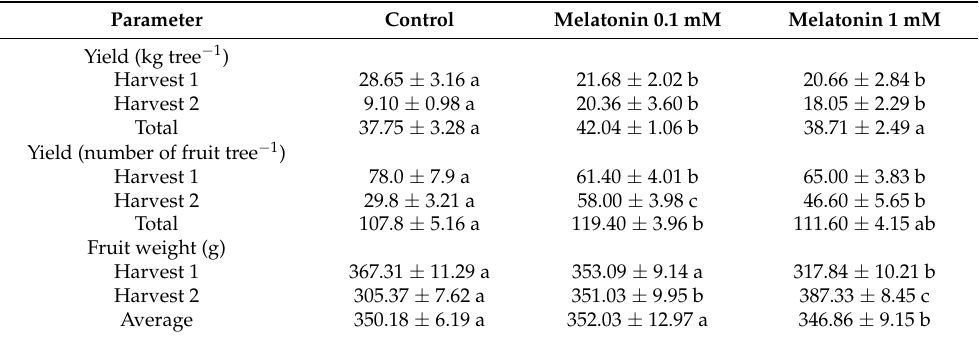
Data are the mean ± SE. For each parameter and harvest date, different letters within a row show significant differences at p < 0.05. Table 2. Data for yield (kg tree − 1 and number of fruit tree − 1 ), total number of fruits in 5 trees and fruit weight in control and 0.1 melatonin-treated pomegranate trees at two harvest dates (1 and 2). Table 1. Data for yield (kg tree − 1 and number of fruit tree − 1 ), and fruit weight in control and Year